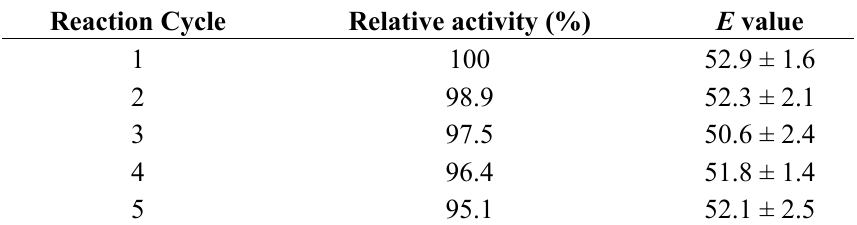
Table 2. Reusability of APE 1547 under microwave irradiation a